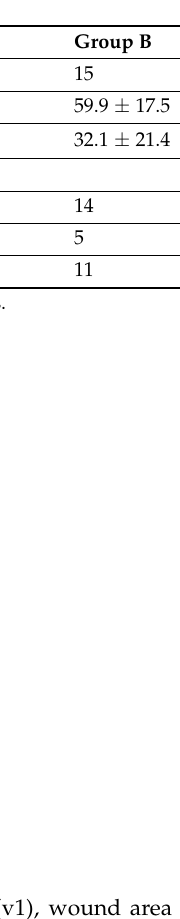
Table 3. Differences in gender, age, wound area, and wound etiology between the populations under exam.